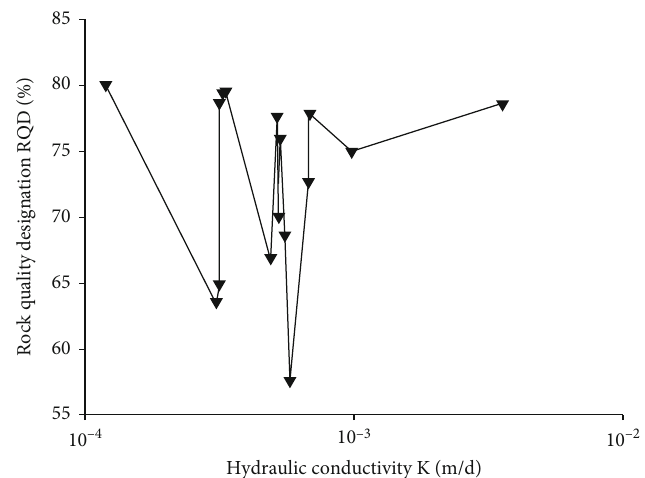
Figure 6: Relationship curve between hydraulic conductivity ( K ) and rock quality designation (RQD).